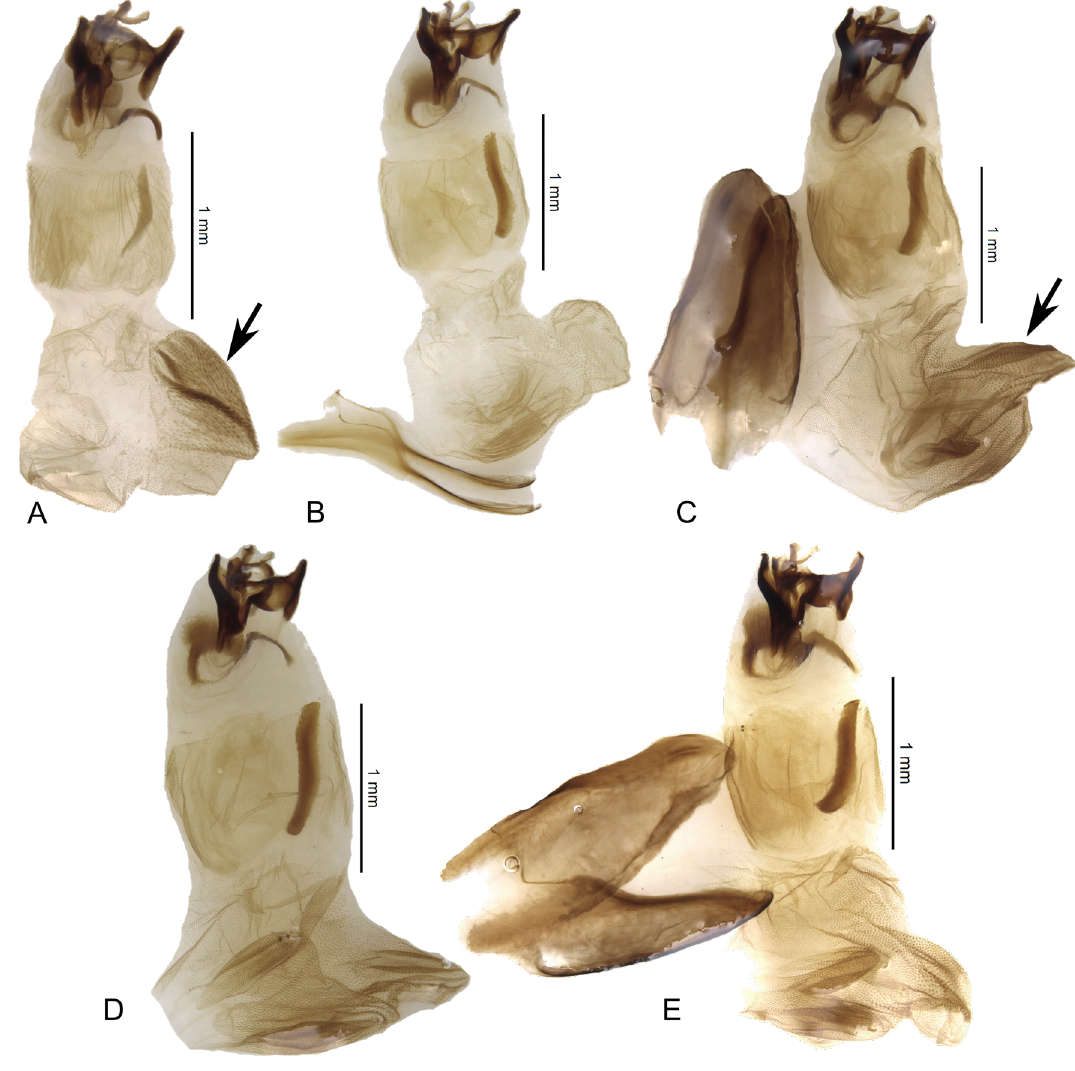
Fig. 8. Endophallus of members of the gilli species group. Arrows show the scales on the sub-medial area of the endophallus. A . Elongate scales. C . Regular scales. A . Holotype of Deltochilum gilli